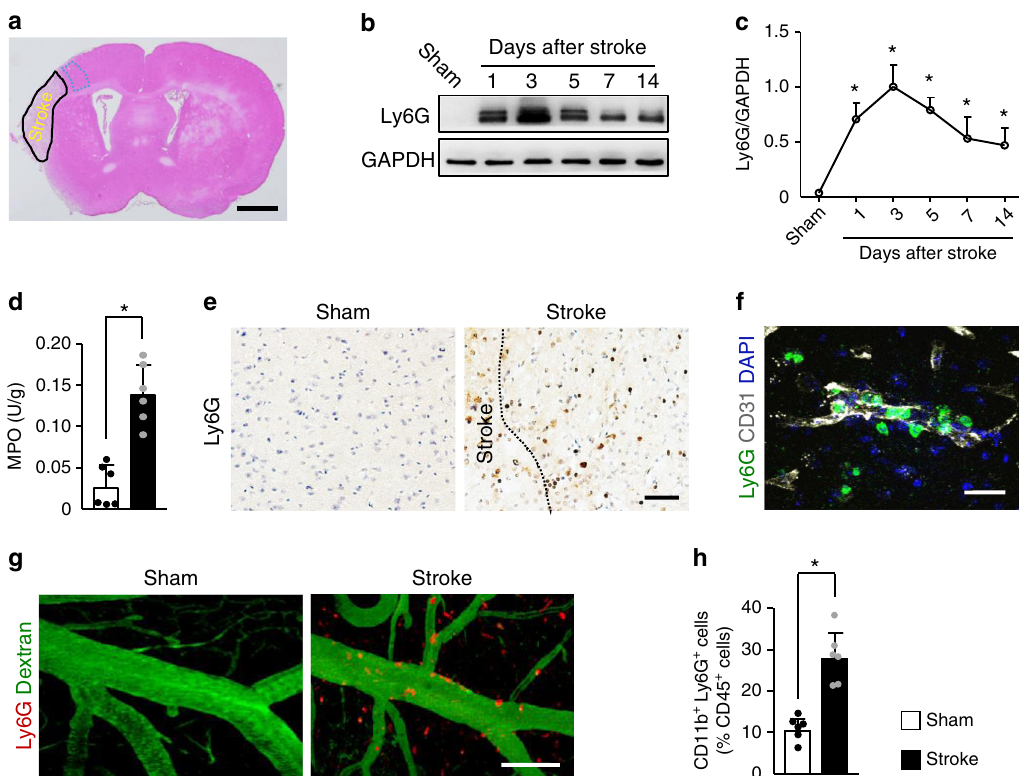
Fig. 1 Neutrophils accumulate in the brain during all stages of ischemic stroke. a Hematoxylin and eosin-stained coronal section shows the zone (broken blue line) used for measurements of IgG extravasation, capillary length, and in-vivo multiphoton microscopy in the peri-infarct cortical areas. Bar = 1 mm. Independent experiments are repeated at least three times. b , c Representative immunoblots of the time course of neutrophils appearance ( b ) and quanti fi cation of the amount of neutrophil ( c ) in the peri-infarct cortex of mice subjected to stroke, compared with sham-operated mice ( n = 5). One-way ANOVA test was applied with * P < 0.0001 (Sham vs. 1d), * P < 0.0001 (Sham vs. 3d), * P < 0.0001 (Sham vs. 5d), * P = 0.0003 (Sham vs. 7d), * P = 0.0015 (Sham vs. 14d). d Quanti fi cation of MPO activity in the brain of mice at 3 days after stroke or sham operation ( n = 6), unpaired two-tailed Student ’ s t -test was applied with * P = 0.0001. e Representative images of Ly6G-positive neutrophils in the peri-infarct cortex of mice at 3 days after stroke, compared with sham-operated mice. Bar = 50 μ m. Independent experiments are repeated at least three times. f Representative confocal images of Ly6G-labeled neutrophils (green) and CD31-positive microvessels (white) in the peri-infarct cortex of mice at 3 days. Nuclei were visualized with Hoechst. Neutrophils were observed within brain vessels and migrated into the parenchyma. Bar = 40 μ m. Independent experiments are repeated at least three times. g Representative in-vivo multiphoton microscopy images of neutrophils (red) and cerebral angiopathy (green) in the peri-infarct cortex of mice at 3 days. Neutrophils were localized in brain vessels and the parenchyma. Blood vessels (green) were labeled by intravenous injection of FITC-dextran (MW = 2000,000 Da). Neutrophils (red) were labeled by intravenous injection of PE-conjugated monoclonal Ly6G antibody. Bar = 100 µ m. Independent experiments are repeated at least three times. h Flow cytometric quanti fi cation of neutrophils (CD11b + Ly6G + cells) in peripheral blood at 3 days after stroke, expressed as percentage of total leukocytes (CD45 + cells) ( n = 6), unpaired two-tailed Student ’ s t -test was applied with * P = 0.0001. Data are presented as mean ± SD. Source data underlying graph b – d and h are provided as a Source Data (Supplementary Fig. 3a). To con fi rm these observations obtained by histological analyses, we identi fi ed NET formation using in- vivo multiphoton microscopic imaging of i.v.-injected Sytox green. This analysis revealed that Sytox green-positive extra- cellular DNA fi bers were not observed in the nonischemic cortex, whereas these fi bers abundantly detected in the peri-infarct cortex at 3 days after stroke (Fig. 3m).